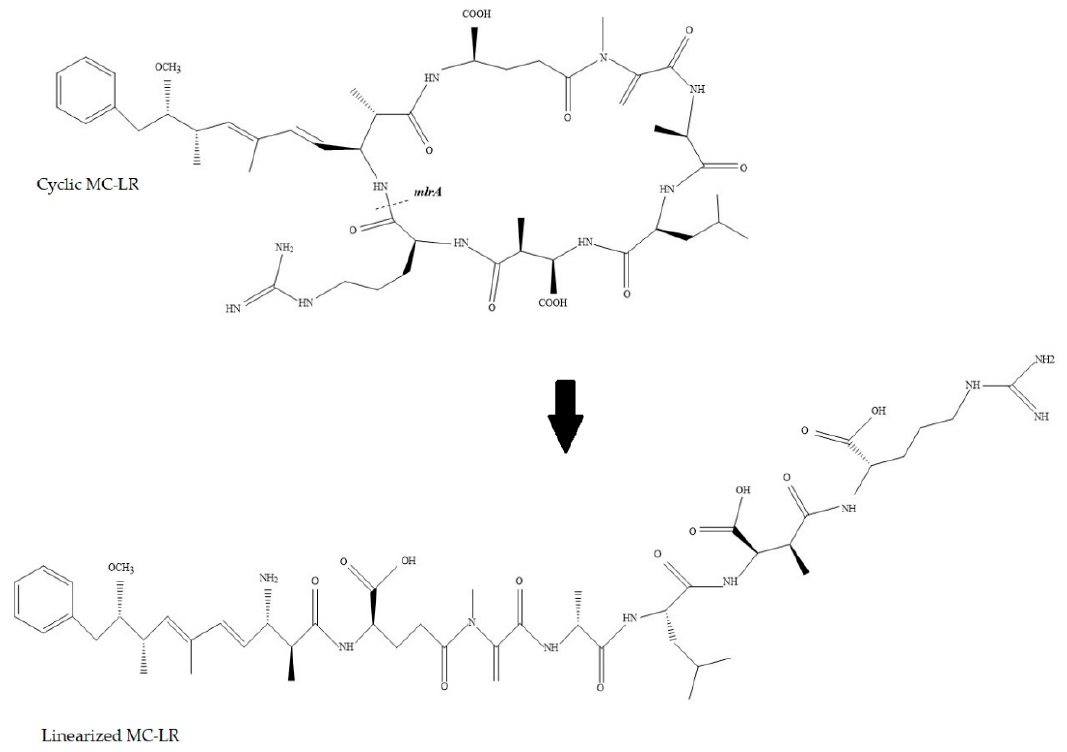
Figure 1. Linearization of Microcystin-LR by microcystinase A.